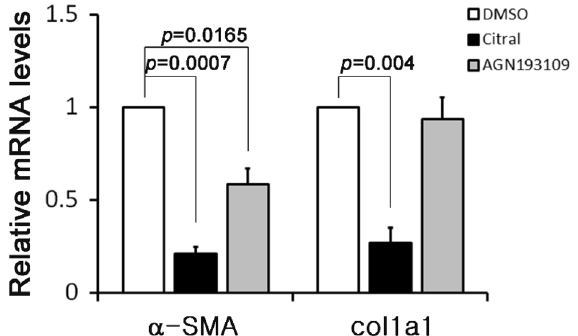
Figure 1. Retinoic acid plays a role in hepatic stellate cell activation. Hepatic stellate cells after passage 1 were treated with citral (100 μM) or AGN193109 (1 μM) for 20 h, and the alpha-smooth muscle actin (α-SMA) and collagen type I alpha 1 (col1a1) expression levels were then analyzed by real-time PCR. The data represent the means ± SD for three independent experiments. P -value, paired t -test (compared with untreated